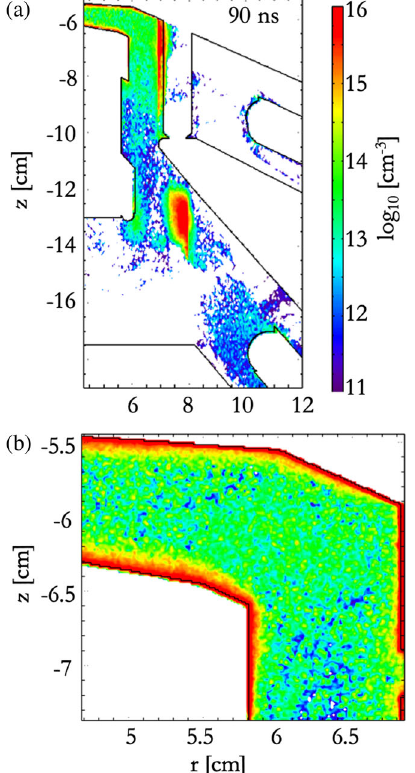
FIG. 11. Ion density contours in the ∅ 15 cm convolute at 90 ns shown for (a) the anode posts ’ surfaces and (b) a magnified view near the inner MITL. The densities are plotted on a log scale from 10 11 − 10 16 cm − 3